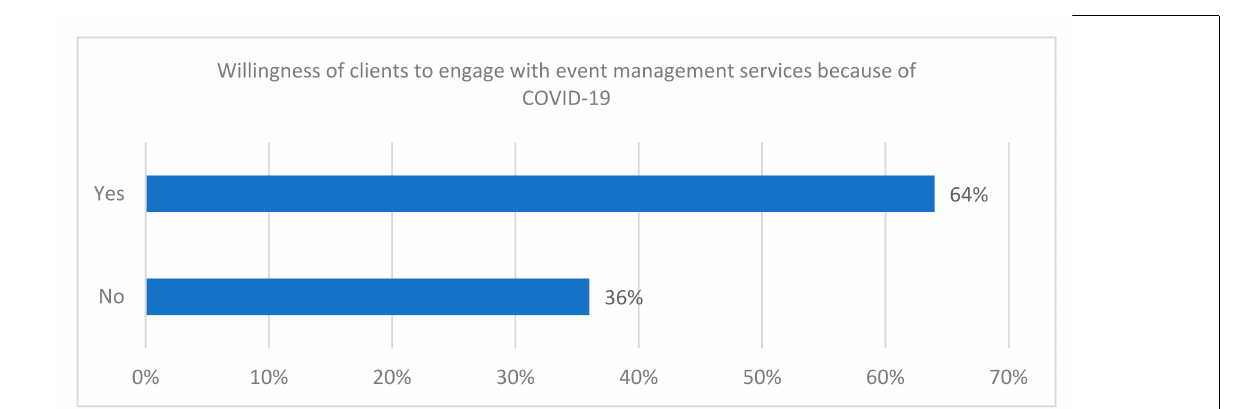
Figure 7. Willingness of clients to engage with event management services because of COVID-19 ( n = 14).